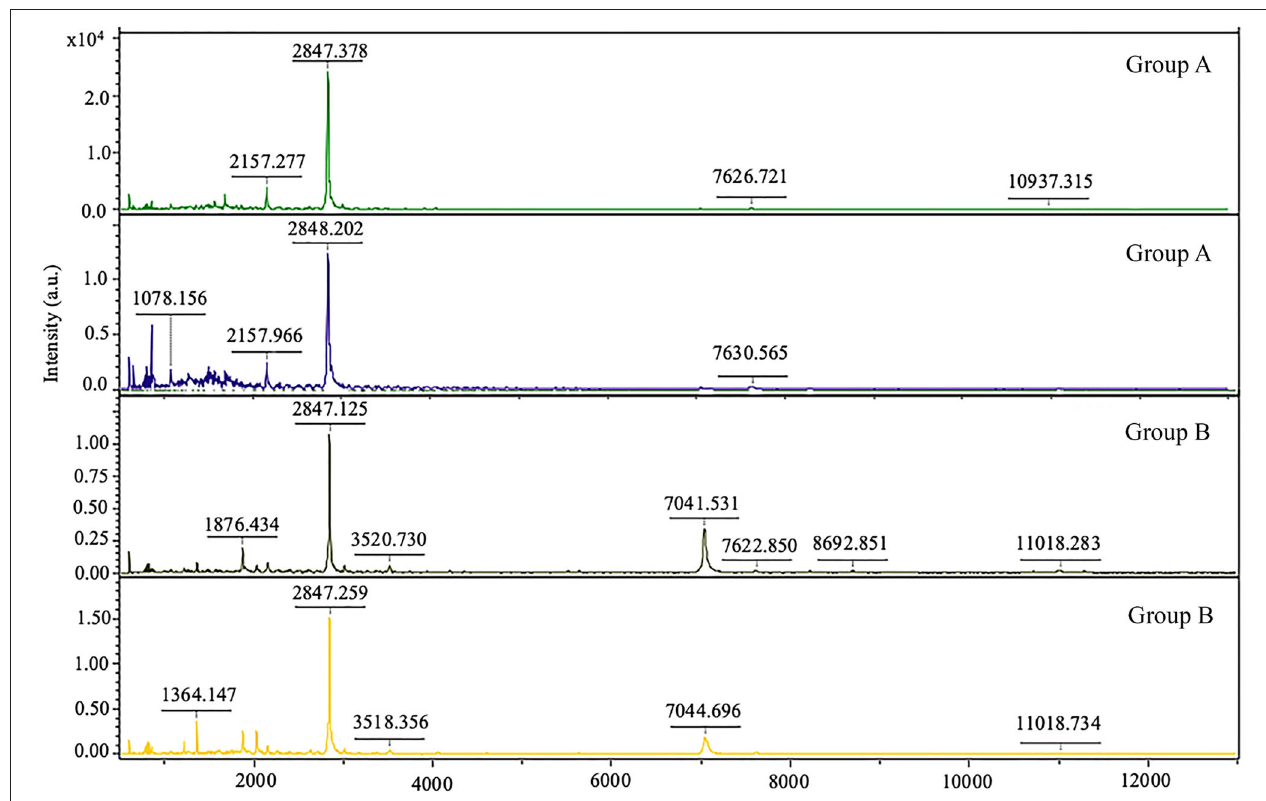
FIGURE 6 | Peptide mass fingerprint of dogs with normal right ventricular function (group A) and dogs with impaired right ventricular function (group